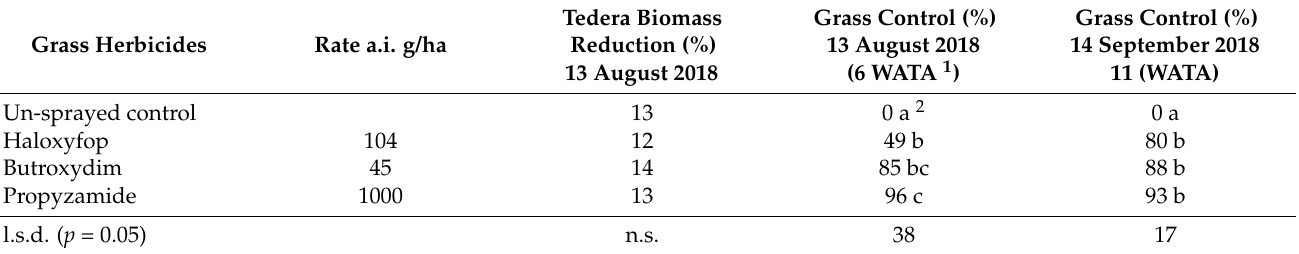
Table 8. Response of grass and a 1-year-old tedera stand to post-emergent grass-selective herbicides applied on 28 June 2018 at Dandaragan (averaged over broadleaf herbicide treatments).